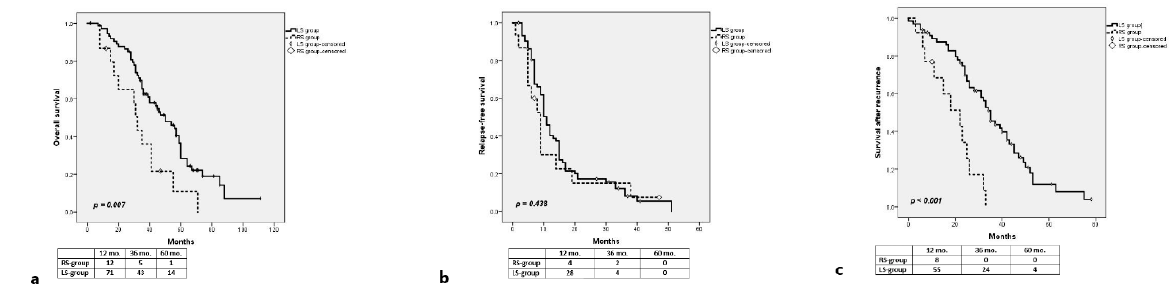
Figure 2. Comparative long-term outcomes between LS group and RS group in patients with RAS-wt